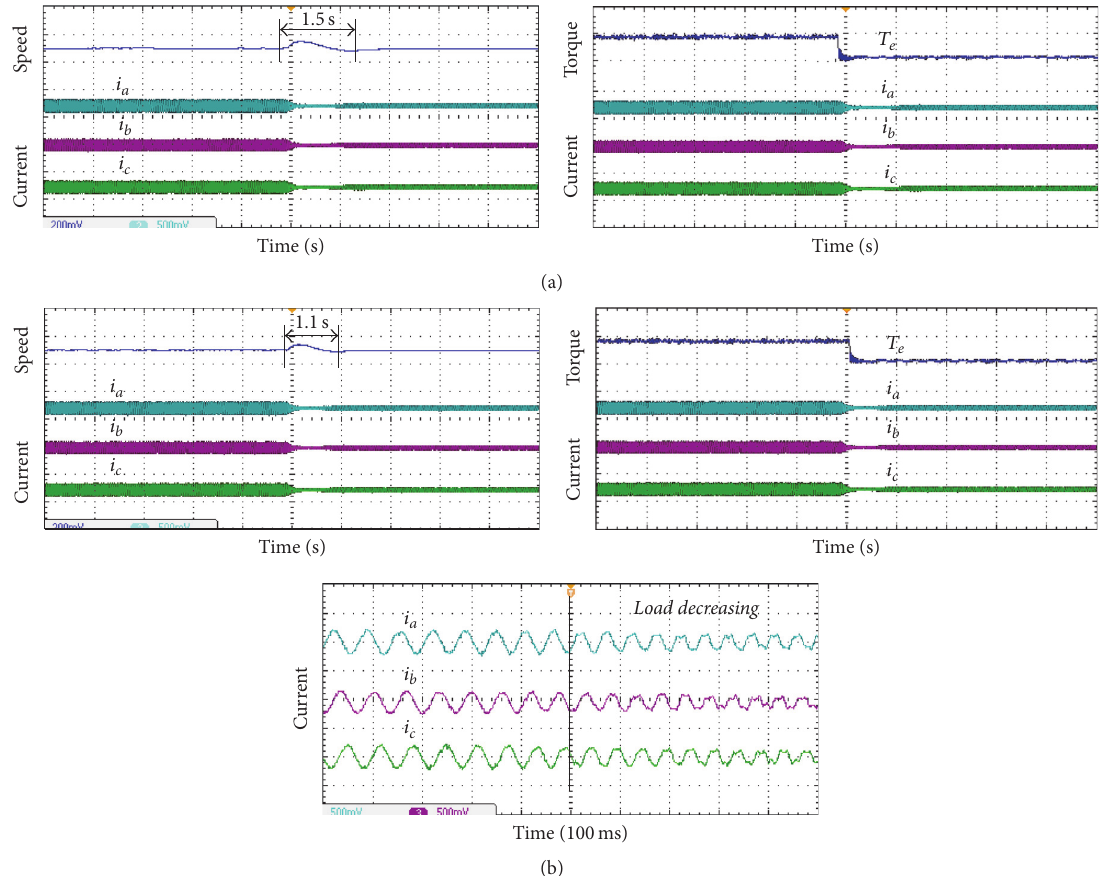
Figure 15: Response when the load suddenly decreases (current (1A/div), speed (200r/min/div), torque (2N ⋅ m/div), and time (1s/div)). (a) The existing SMC control strategy. (b) The proposed SMC control strategy.